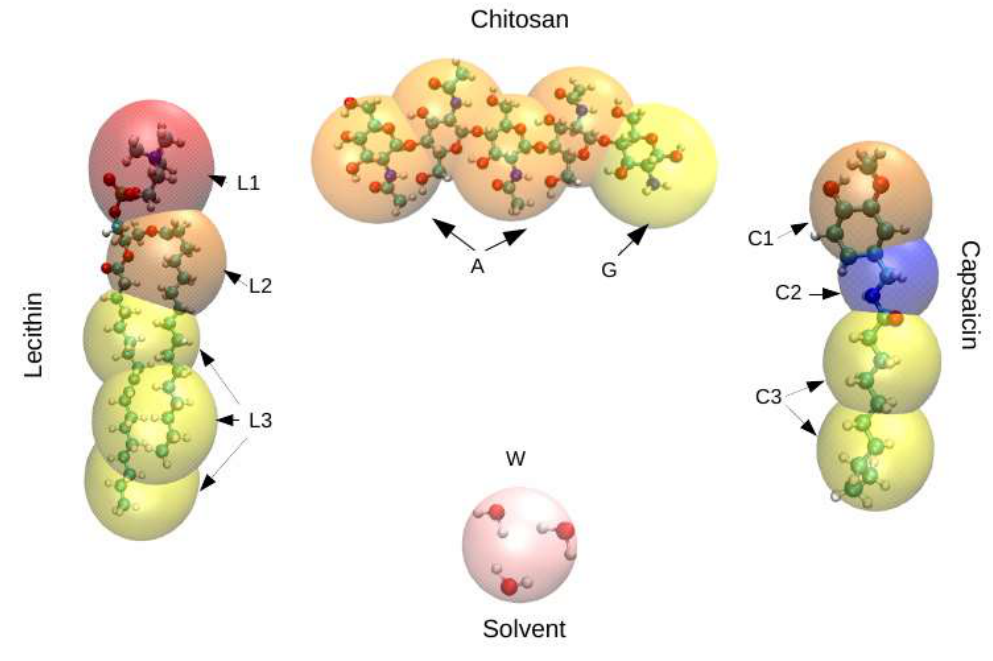
Figure 1. Schematic representation of the coarse-grained models adopted in this work. Mesoscopic models for lecithin (C 42 H 82 NO 8 P, left) , chitosan (CS) ( top center ), water as solvent ( bottom center ), and capsaicin (C 18 H 27 NO 3 , right ). The exact division of every functional group is presented in the SI. As an overview, the molecular structure of lecithin is composed of three different beads, which we have labelled as L 1, L 2, and L 3, that correspond to the head, neck and tail groups, respectively. The same nomenclature is used for capsaicin, where the beads C 1, C 2, and C 3 correspond to the head, neck, and tail groups, respectively. The CS model consists of two types of beads: the first bead represents the glucosamine units (C 6 H 13 NO 5 ), which are labelled G , while the second bead represents the N -acetyl-glucosamine units (C 8 H 15 NO 6 ), which are labelled A . Finally, the solvent (water) is represented by bead W . These figures were prepared with the Visual Molecular Dynamics (VMD) package [53].